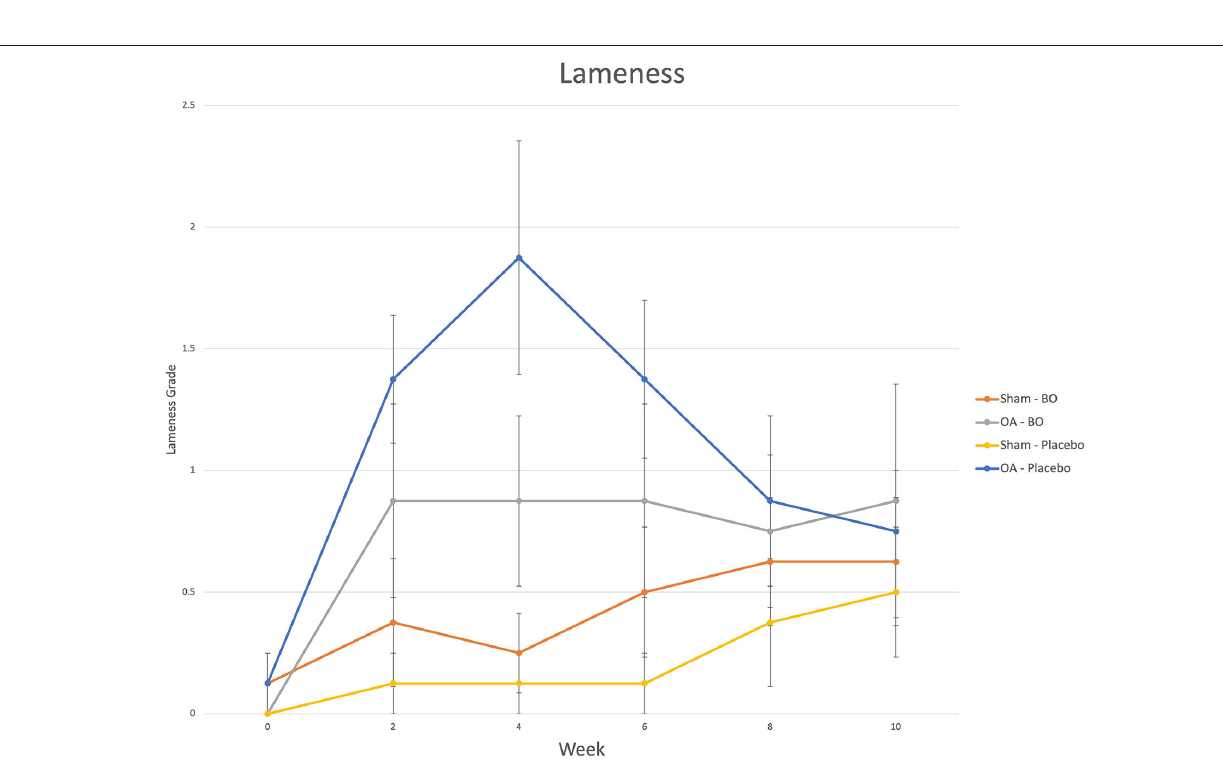
Frontiers in Veterinary Science | www.frontiersin.org 5 June 2022 | Volume 9 | Article